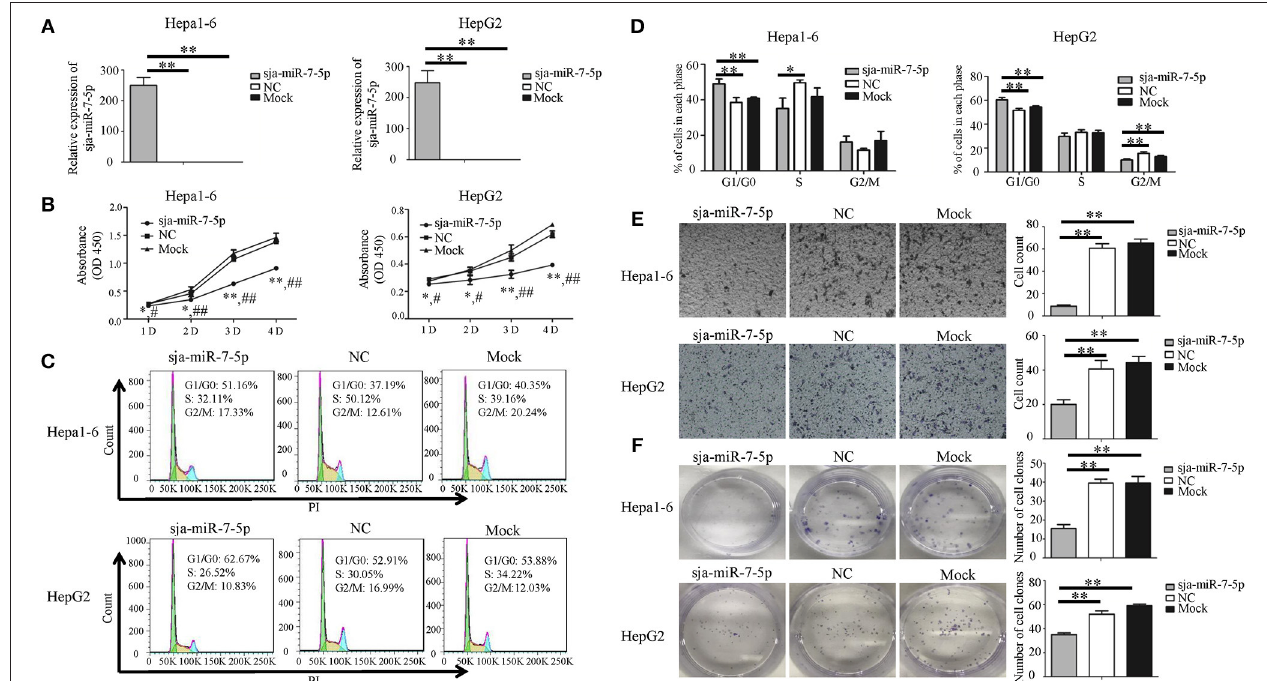
FIGURE 2 | Sja-miR-7-5p inhibits cell proliferation and migration of Hepa1-6 and HepG2 cells in vitro . (A–F) Hepa1-6 and HepG2 cells were transfected with sja-miR-7-5p mimics and NC (negative control) mimics, respectively, and 48h later [except for the cell counting kit-8(CCK-8) assay, which was 24h later], the expression of sja-miR-7-5p was determined using qRT-PCR (A). Cell proliferation was evaluated by CCK-8 assay at 1, 2, 3, and 4 days (B) , data are presented as the mean ± SD, n = 3, * p < 0.05 or ** p < 0.01 indicates the comparison between the two groups of sja-miR-7-5p and NC; # p < 0.05 or ## p < 0.01 indicates the comparison between the groups of sja-miR-7-5p and Mock. Cell cycle was determined by flow cytometry analysis (C,D) . Cell migration was evaluated using Transwell inserts without matrigel coating (E) . The ability to form cell clones was determined using a colony formation assay (F) . Data are presented as the mean ± SD, n = 3, * p < 0.05, ** p <